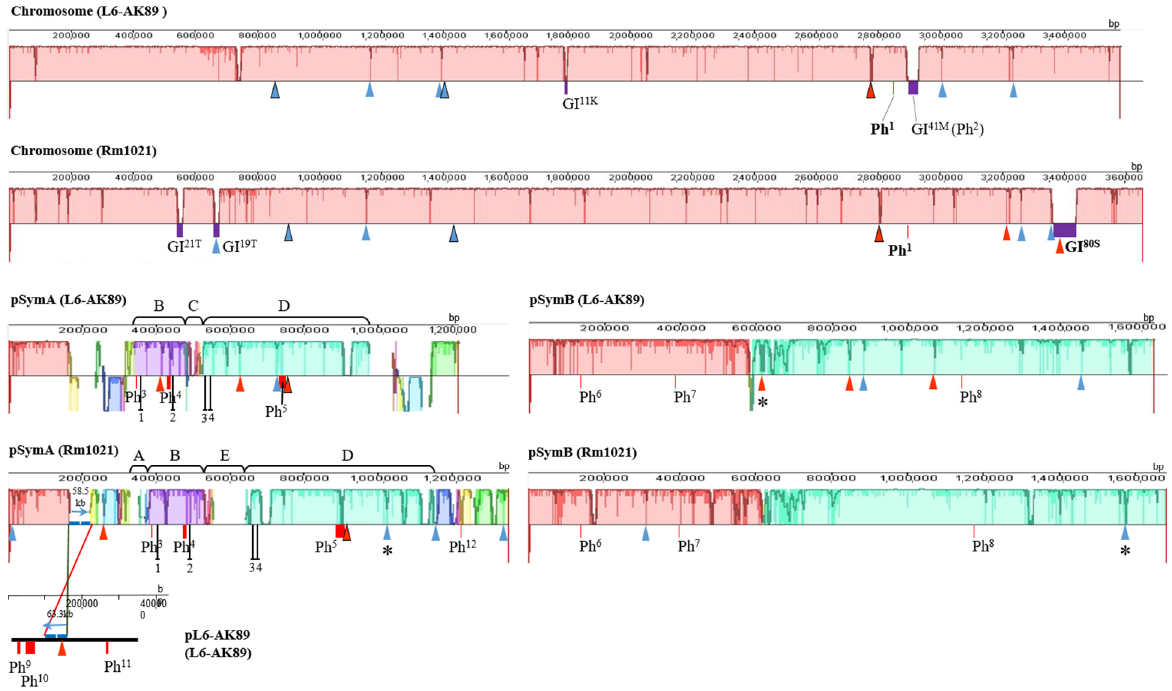
Figure 2. Full-genome analysis of E. meliloti L6-AK89 compared with reference Rm1021. Designations: / . Figures framed in black have identical Width of rectangle